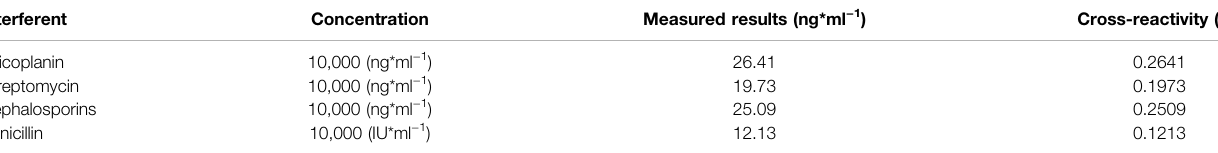
TABLE 2 | Speci fi city of the proposed method for